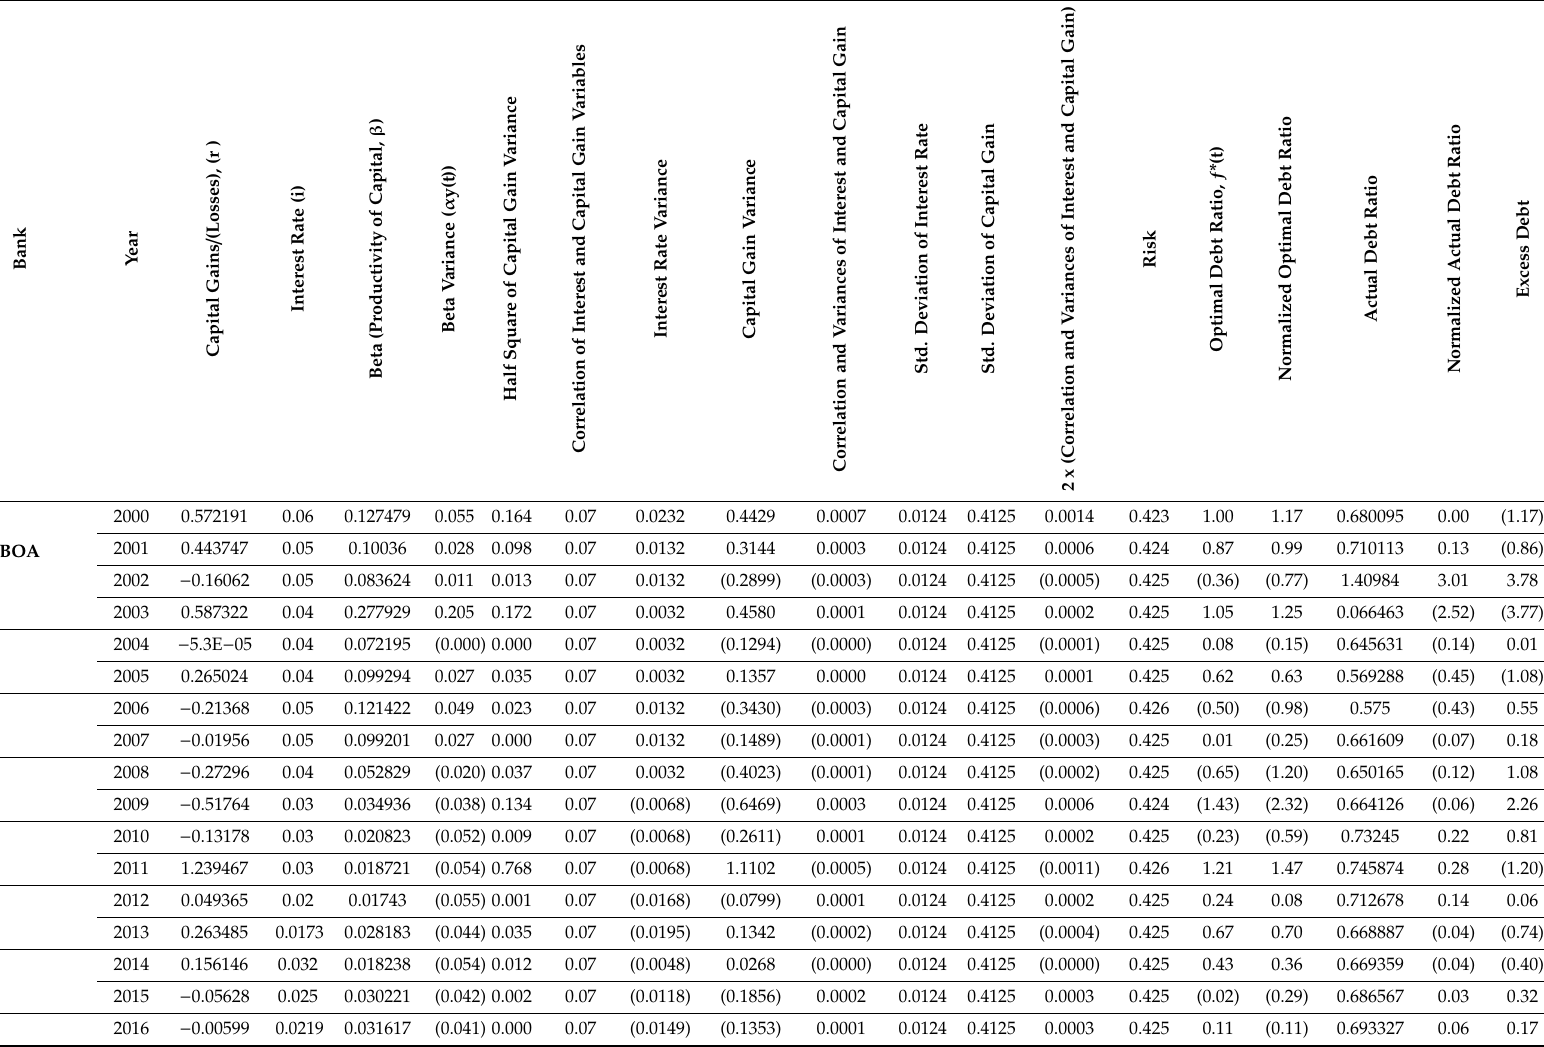
Table A14. Calculations of Optimal and Excess Debt: